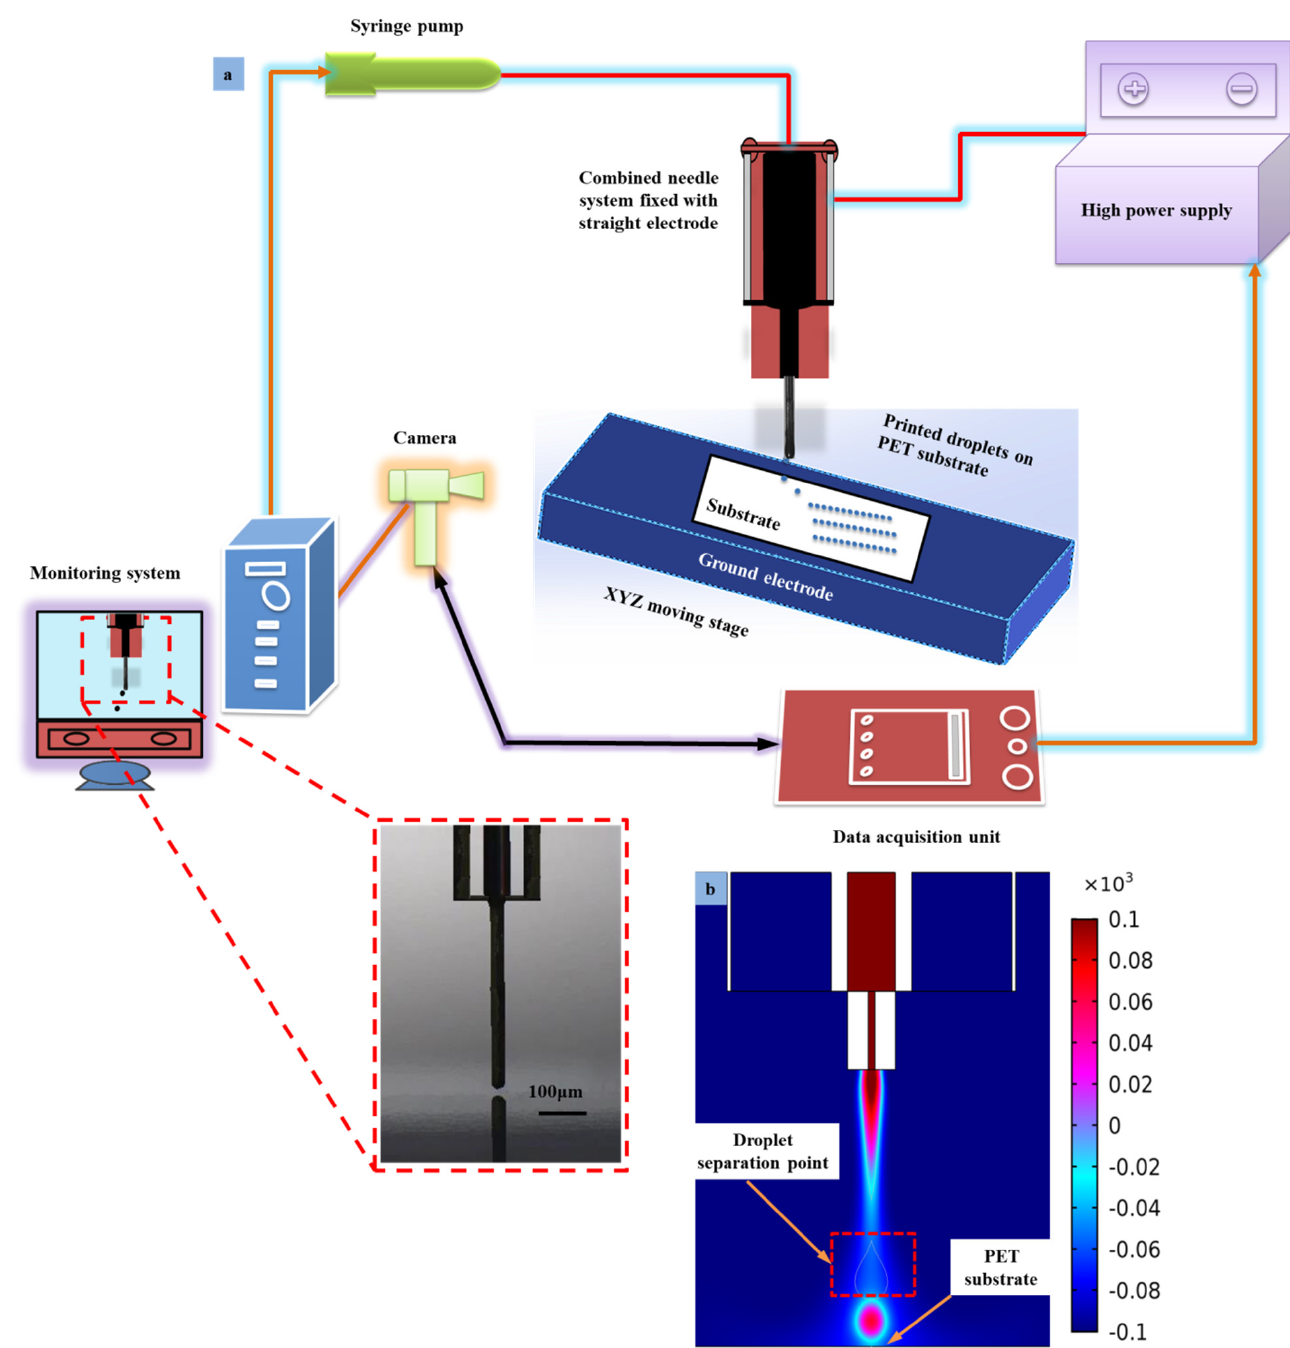
Figure 12. ( a ) Schematic of DoD e-jet printing process equipped with the straight electrode needle system, ( b ) formation of microdroplets during numerical simulation.